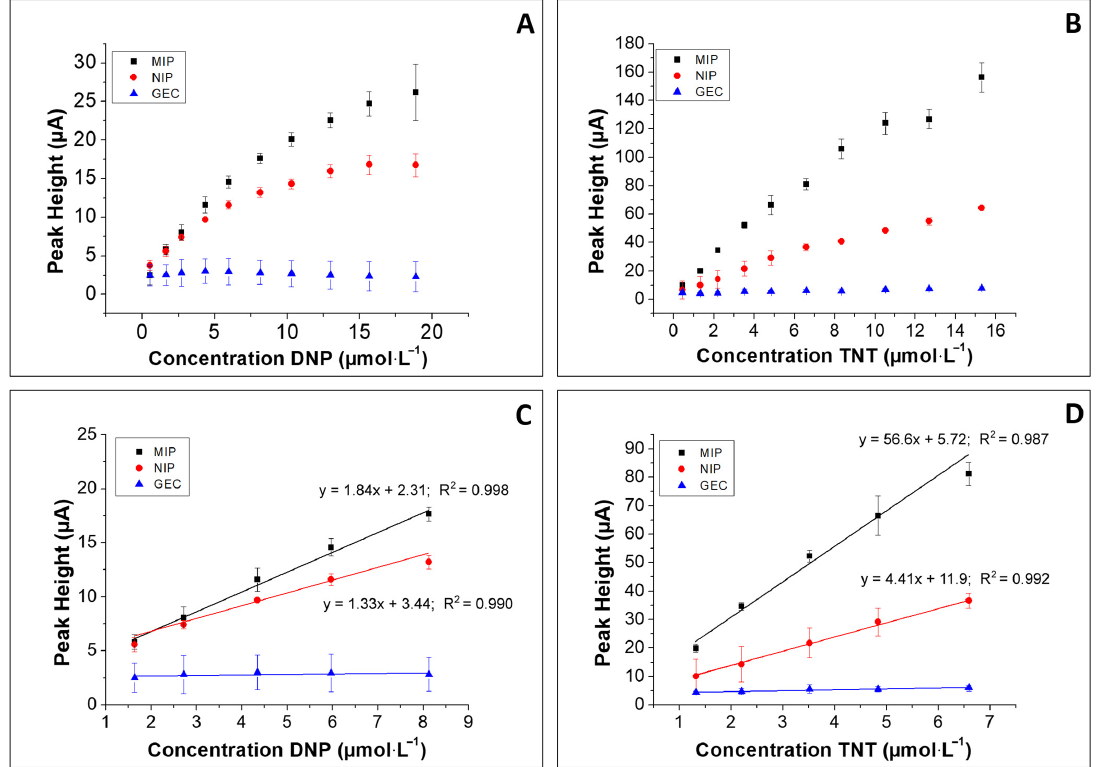
Figure 6. Calibration curves from 0.55 to 19 µ mol L − 1 for DNP ( A ) and from 0.45 to 15 µ mol L − 1 for TNT ( B ) for the three different sensor types used in this study. Linear ranges from 1.6 to 8.0 µ mol L − 1 for DNP and from 1.3 to 6.5 µ mol L − 1 for TNT are added in ( C , D ).